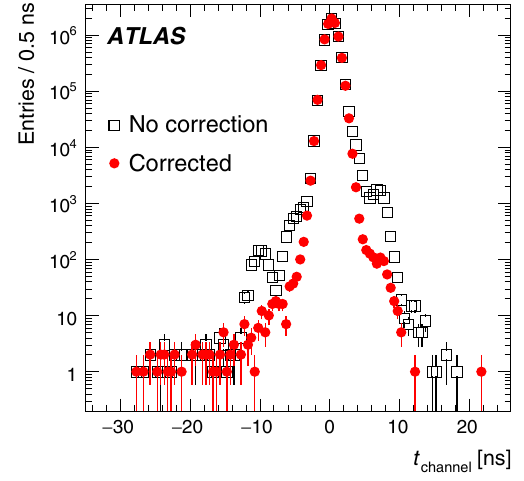
Fig. 7 Impact of the timing jump corrections on the reconstructed channel time in jets from collision data. Shown are all high-gain chan- nels with E ch > 4 GeV associated with a reconstructed jet. The plot represents 1 . 3fb − 1 of pp collision data acquired in